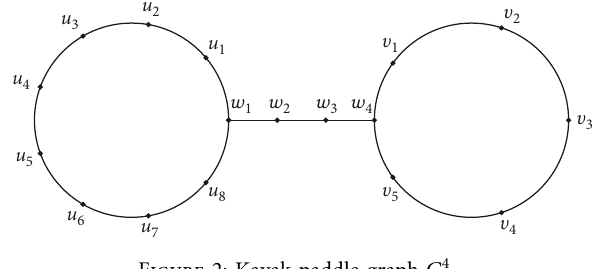
G l for n 8, m 5, and l 4. n,m (cid:31) (cid:31) (cid:31) is presented in the next n,m